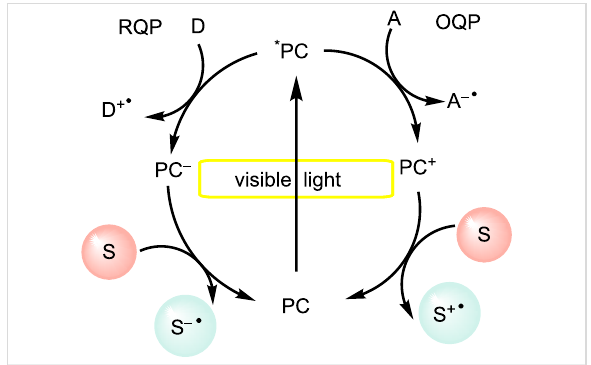
Figure 4: Photoredox catalysis via reductive or oxidative pathways. D = donor, A = acceptor, S = substrate, PC = photoredox catalyst, RDP = reductive quenching pathway, OQP = oxidative quenching pathway.